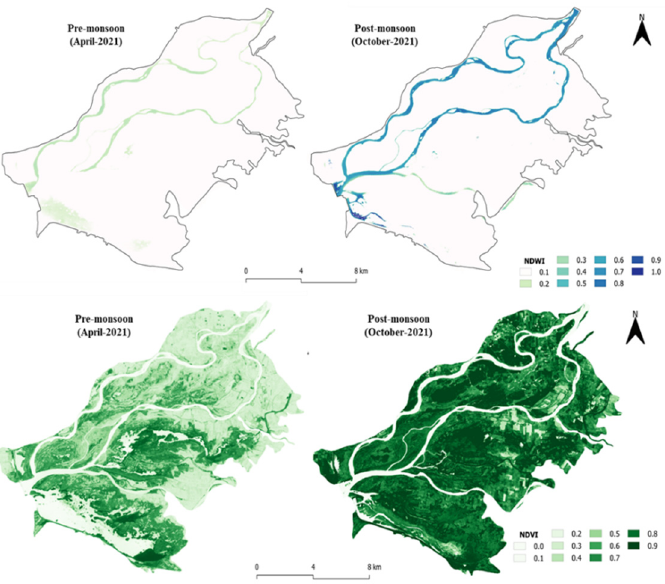
Figure 2. Spatial Variations of Normalised Difference Water Index (NDWI) and Normalised Difference Vegetation Index (NDVI) over Harike Wetland for year 2021 during pre- and post-monsoon season.